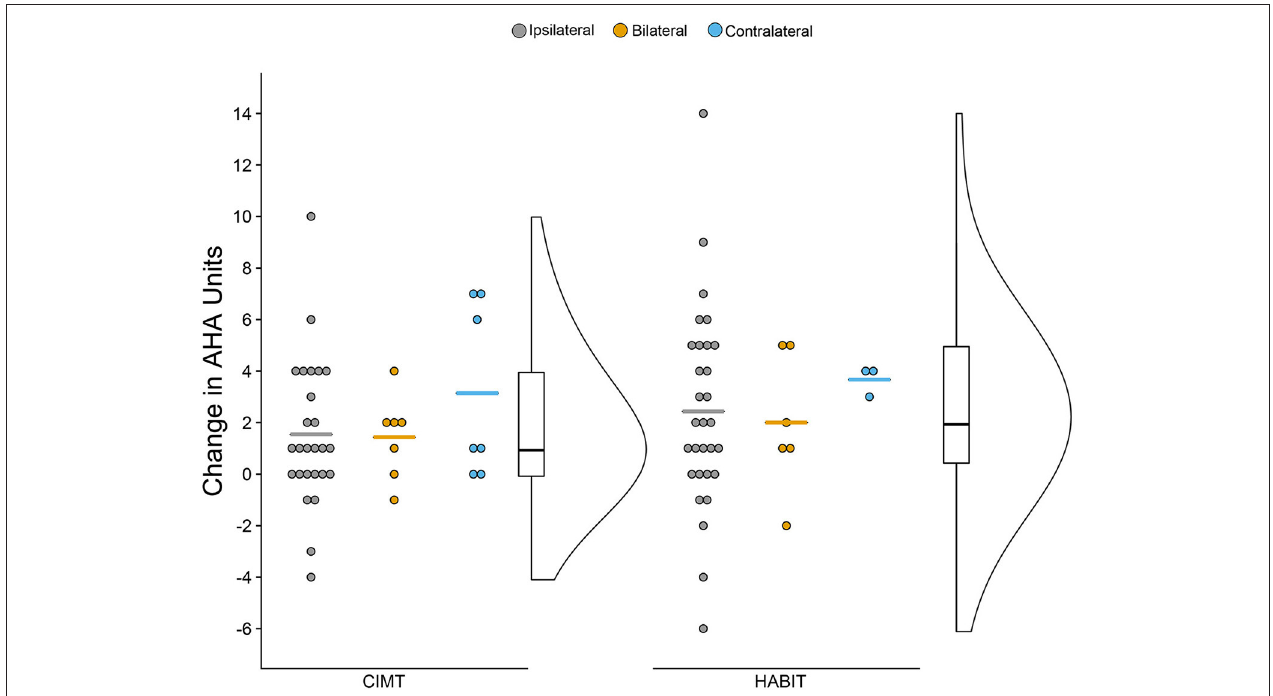
FIGURE 2 | Raincloud Plot of Changes (Pre-test to Post-test) in AHA by Therapy Group and CST Connectivity. Dots represent raw change scores for individual children (positive scores = improvements). Horizontal colored lines represent mean of CST group. Boxplots represent median and quartiles of therapy group data. Curve represents probability distribution of therapy group